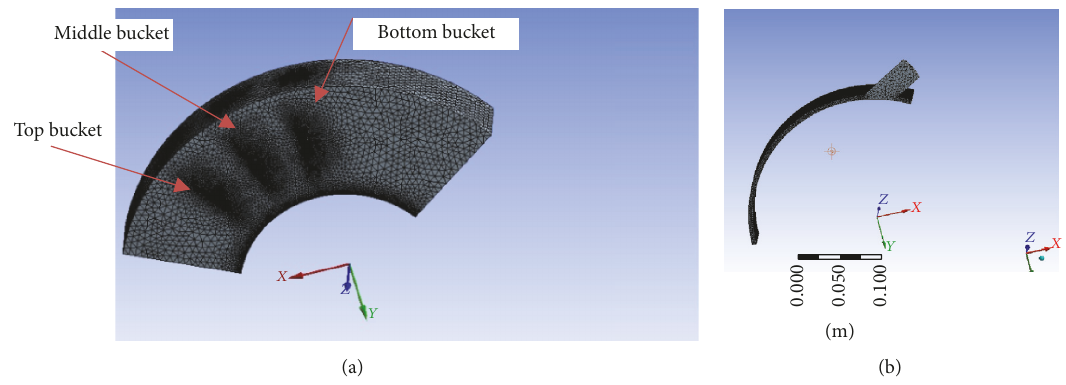
Figure 8: Meshed rotating (a) and stationary domain (b) sizing and inflations were